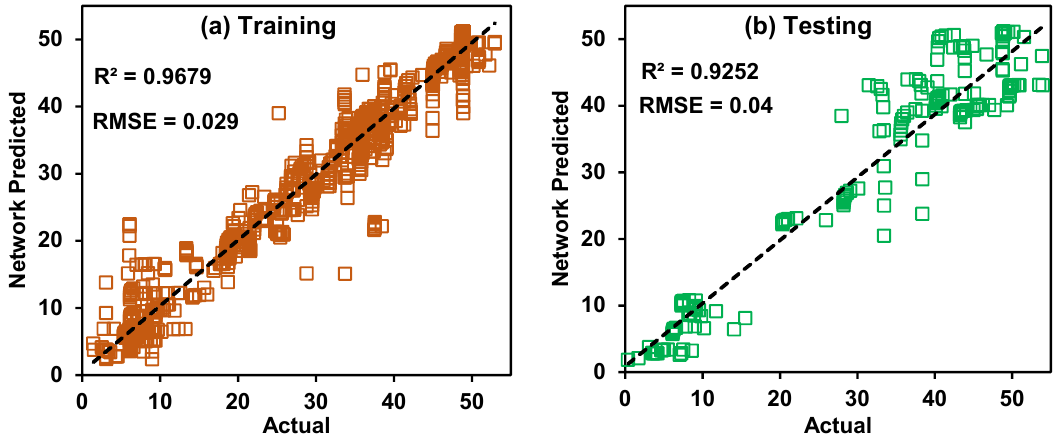
Figure 5. ( a ) Training ( b ) testing of NN 1 using Sigmoidal function indicating the R 2 and RMSE for the optimized model. The optimized NN 1 model with six neurons using tanh as the activation function is used for training the data. It is noted from Figure 6a,b that the network calculated battery output data is in line with the actual battery values. The highly sensitive Nu